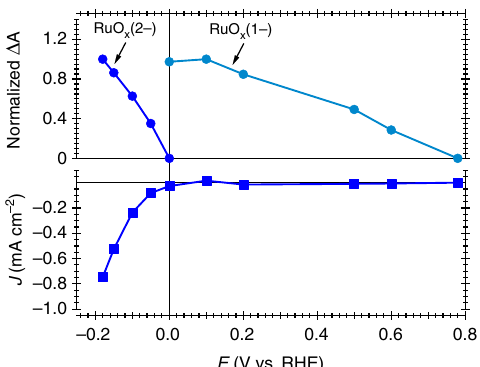
Figure 4 | Correlation between the changes in absorbance and current. The D A was calculated as an average of the optical signal between 850 and 900nm and represented in a normalized scale for clarity. The steady state current density was calculated as the average current measured within 300–350s (see Supplementary Fig.